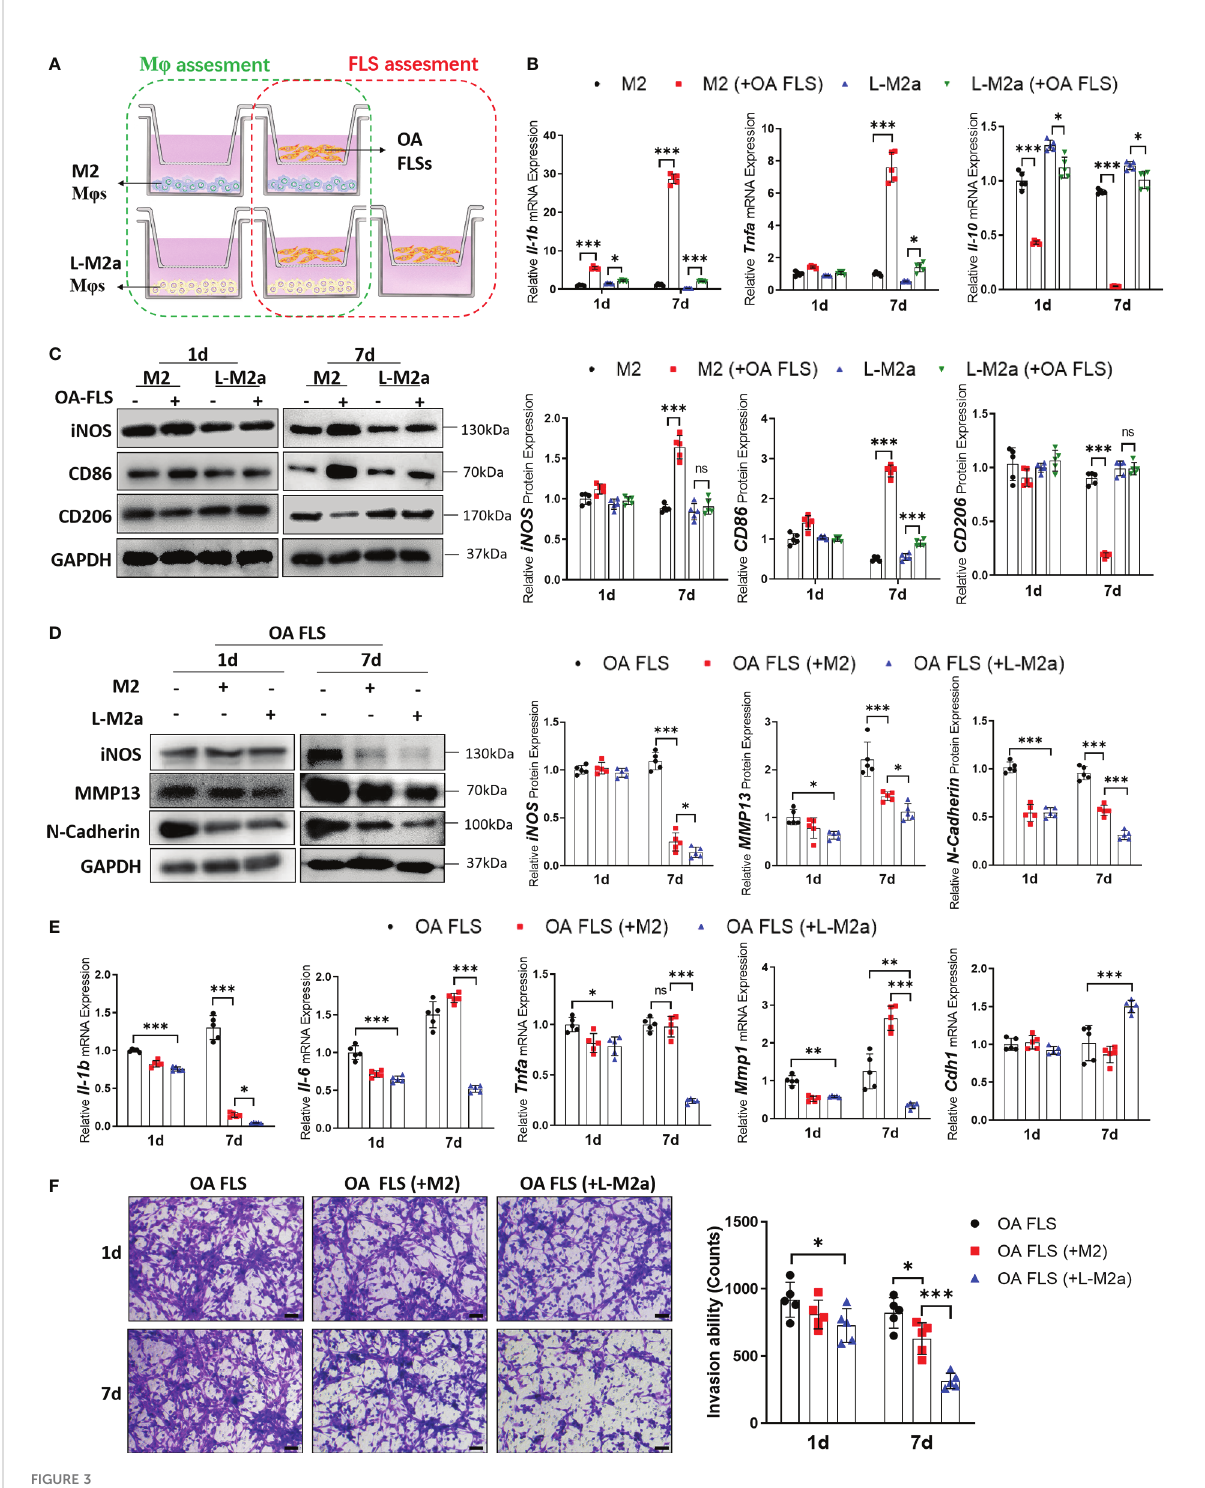
FIGURE 3 L-M2a M j had potent anti-in fl ammatory effects in crosstalk with OA-FLS. (A) Illustration of transwell co-culture system of M j s and OA FLSs. (B, C) Polarized phenotype and in fl ammatory phenotype of M2 and L-M2a M j co-cultured with or without OA FLS for 1 or 7 days using RT- qPCR (B, n=5) and Western blot (C, n=3). (D, F) Assessment of EMT markers (D) , in fl ammation factors (D, E) and invasion activity (F, bar= 100 m m) in OA-FLS co-cultured with control, M2 or L-M2a M j . ∗ p < 0.05; ∗∗ p < 0.01; ∗∗∗ p < 0.001. ns, no signi fi cance; M j , macrophage; L-M2a M j , locked M2a macrophage; FLS, fi broblast-like